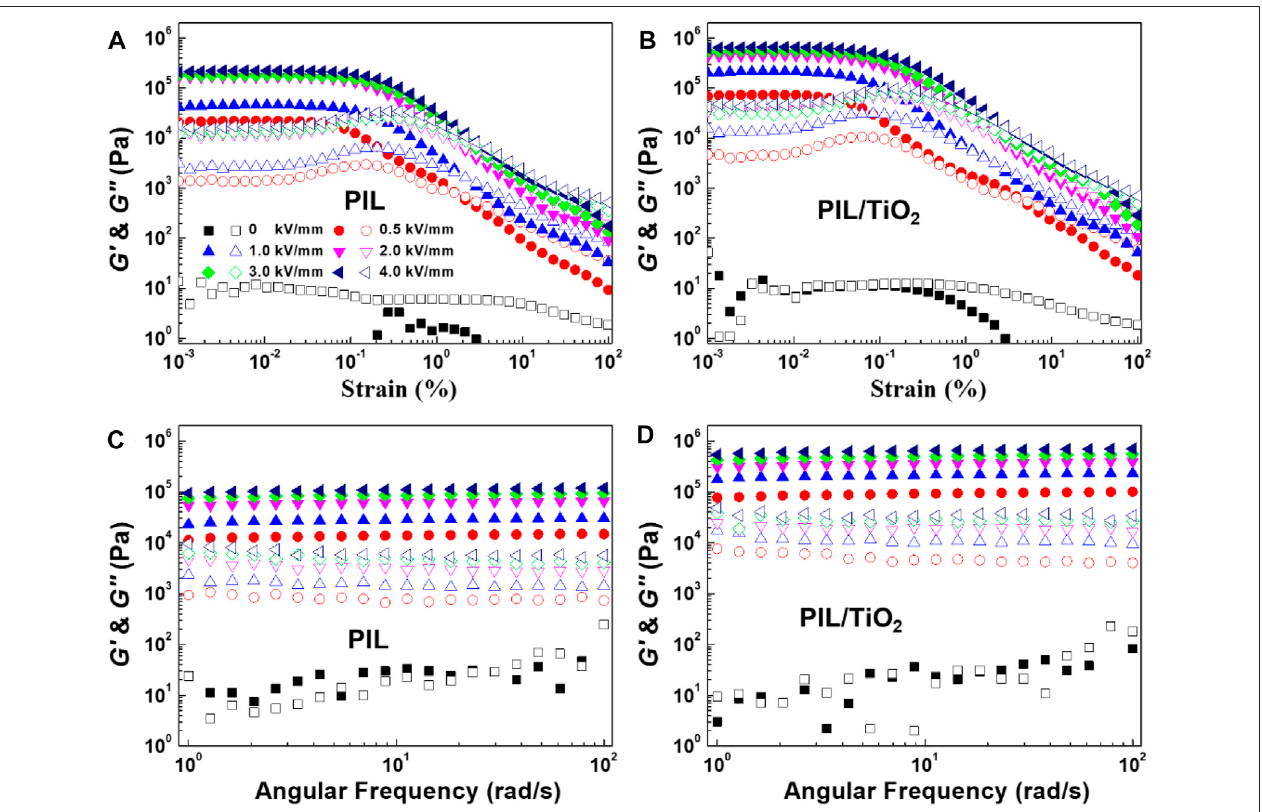
FIGURE 7 | Amplitude (A,B) and angular frequency (C,D) sweep curves of the ER fl uids of PIL (A,C) and PIL/TiO 2 (B,D) at 25 ° C under different electric fi eld strengths.